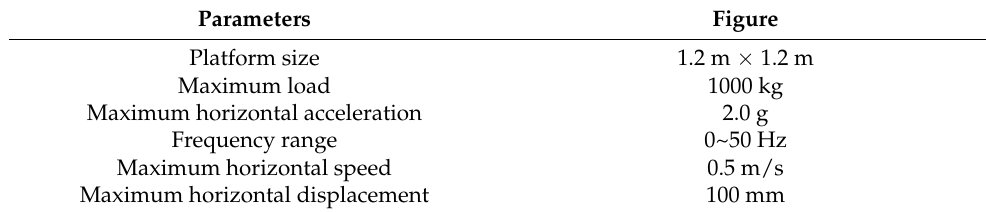
Table 1. Parameters of the shaking table